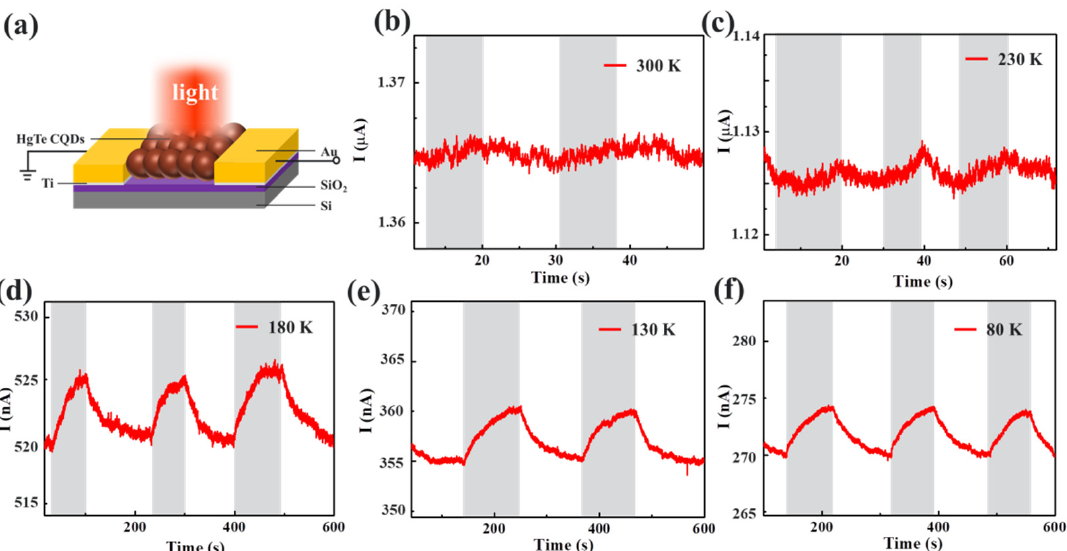
Figure 6. ( a ) Schematic diagram of the structure of the HgTe CQDs photoconductive device; I–t diagrams of the devices at 300 K ( b ), 230 K ( c ), 180 K ( d ), 130 K ( e ), and 80 K ( f ) under 2000 nm illumination, respectively.